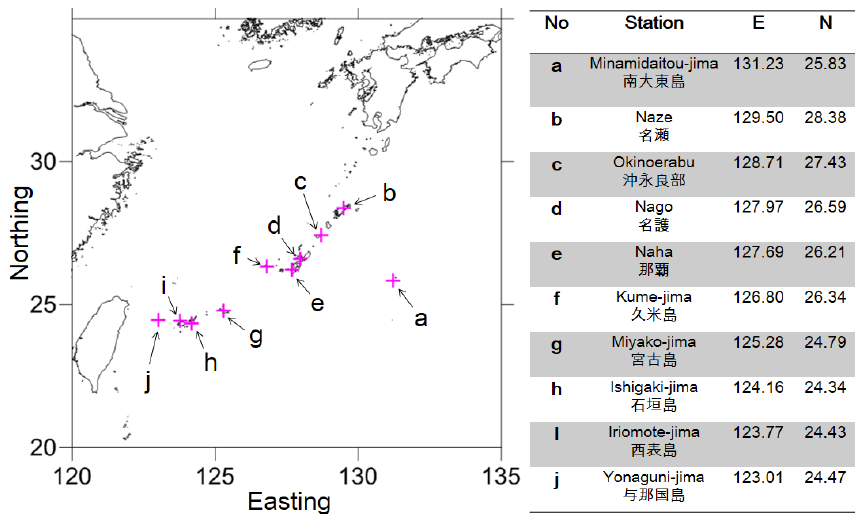
Figure 1. Ten meteorological stations along the Japanese archipelago operated by the Japan Meteorological Agency (JMA): Minamidaitou- jima (a) , Naze (b) , Okinoerabu (c) , Nago (d) , Naha (e) , Kume-jima (f) , Miyako-jima (g) , Ishigaki-jima (h) , Iriomote-jima (i) , and Yonaguni- jima (j) .